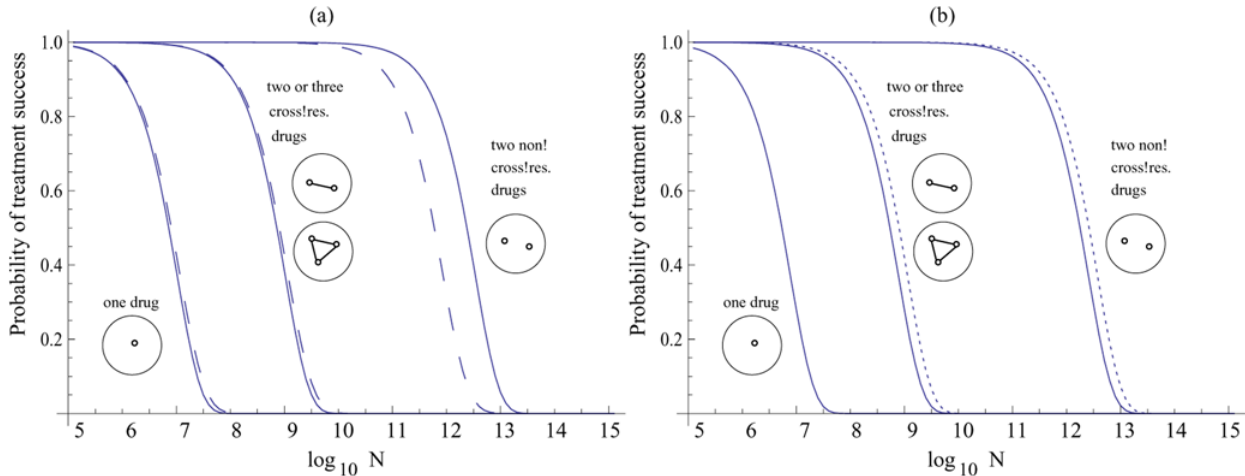
Figure 3. The dependence of treatment success on parameters. (a) The role of the natural death-rate of the cancer cells: d/l=0 (solid lines) and d/l=0.8 (dashed lines); h/l=10 . (b) The role of the drug-induced death rate: h/l=3 (solid lines) and h/l=400 (dotted lines); d/l=0 . Other parameters are the same as in figure 1.